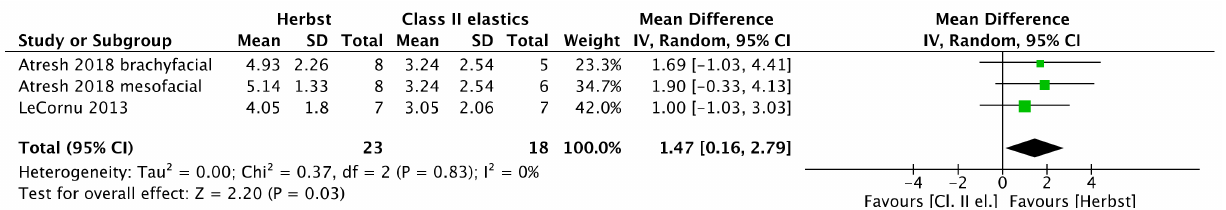
Figure 18. Forest plot of the left mandibular length changes using the random effects model